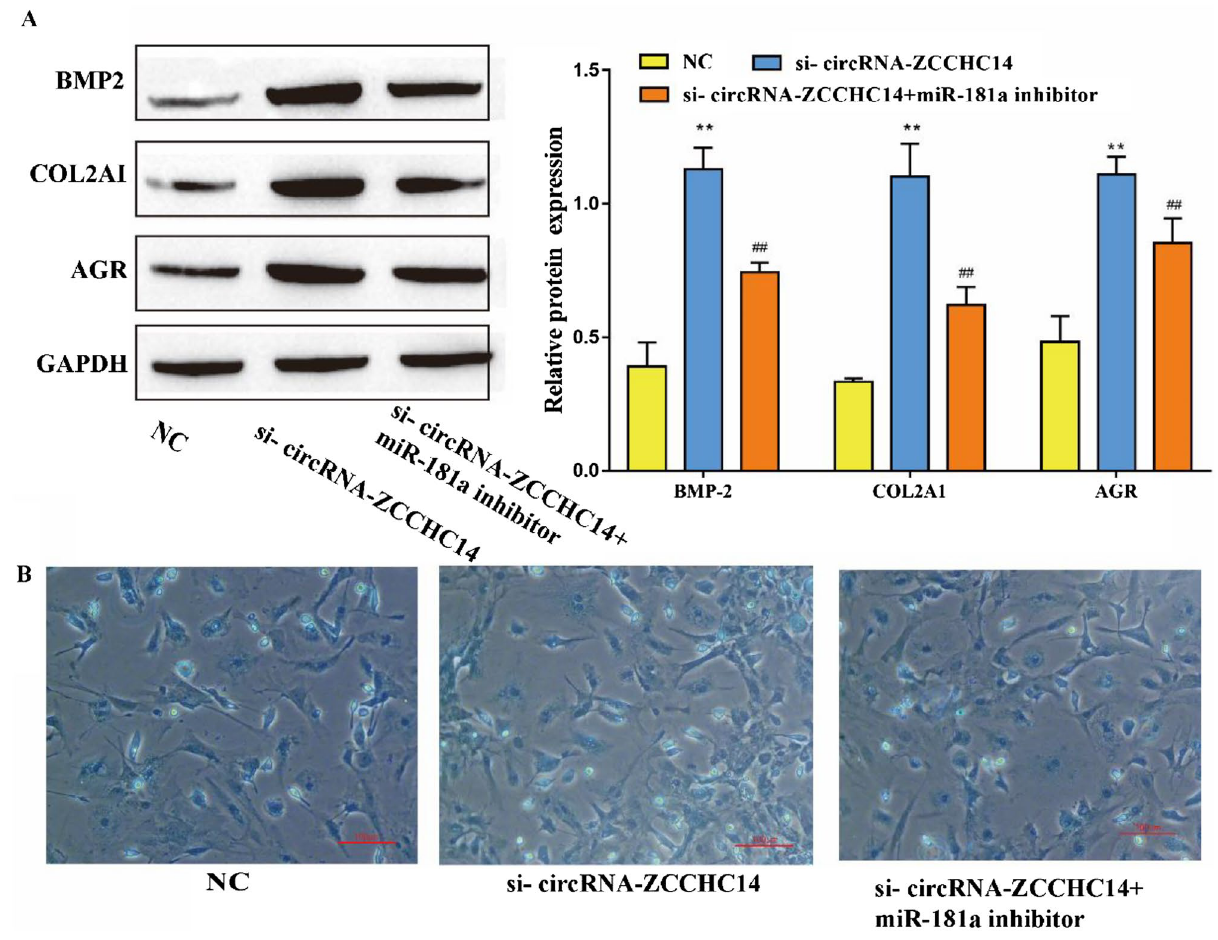
Figure 4. circRNA-ZCCHC14 affects PBMSC chondrogenic differentiation through miR-181a ( A ) Western blot detection of the cartilage markers BMP2, COL2A1 and AGR; ( B ) Alcian blue staining to detect the ability of cells to form